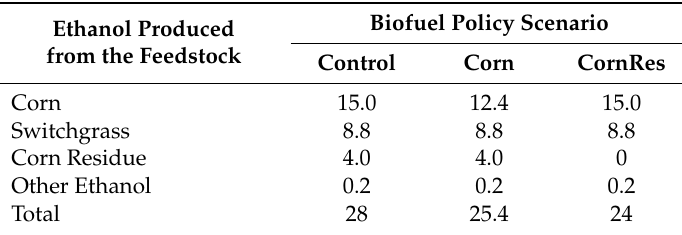
Table 2. Biofuel policy scenario specifications for production in the years 2020 to 2030 with feedstock and volume mandates in billion